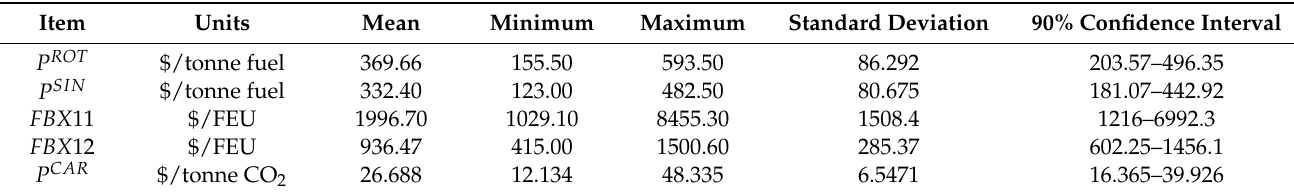
Table 5. Statistics of the